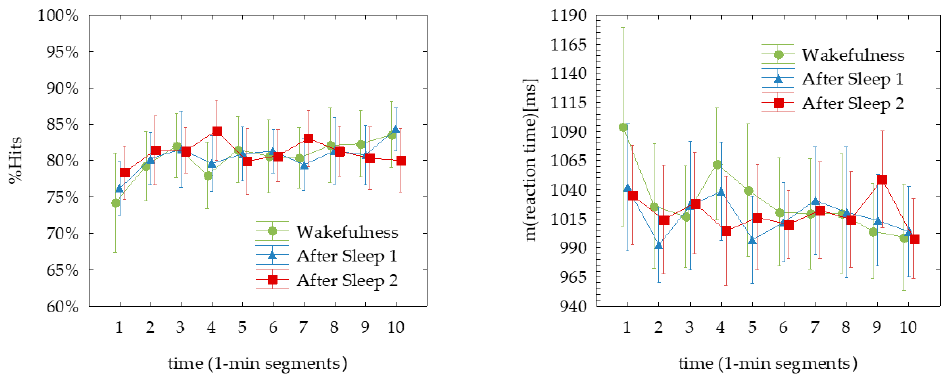
Figure 7. Proportion of hits of the SICD ( left ) and mean reaction times ( right ) for drivers after wakefulness, and twice after sleep.